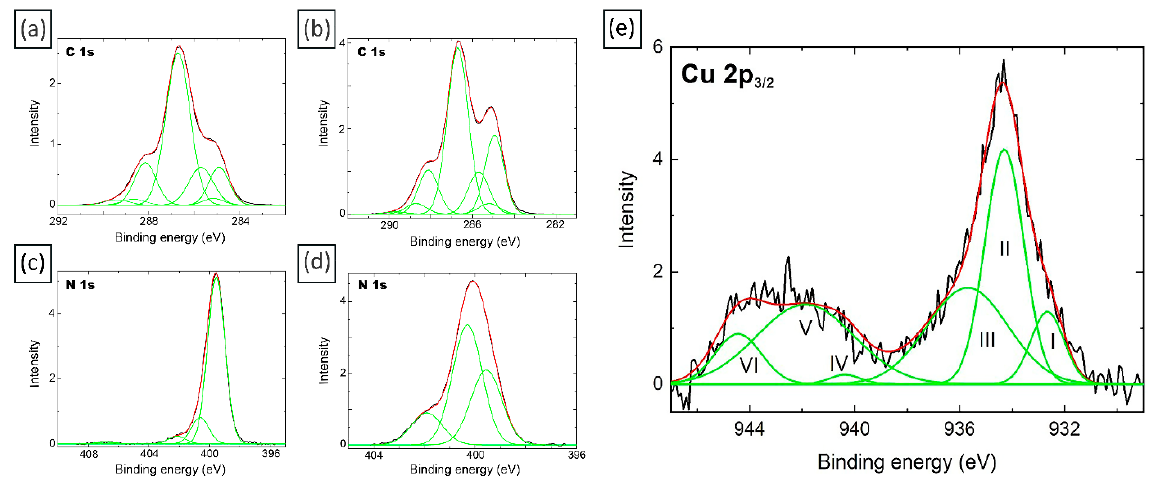
Figure 4. C 1s and N 1s X-ray photoelectron spectra of the original chitosan—( a , c )—and the 1-week Cu/CS composite—( b , d ); ( e ) Cu 2p 3/2 spectra (low molecular weight chitosan, molar ratio Cu/CS = 1/5).The roman numerals identify the numbers of peaks.